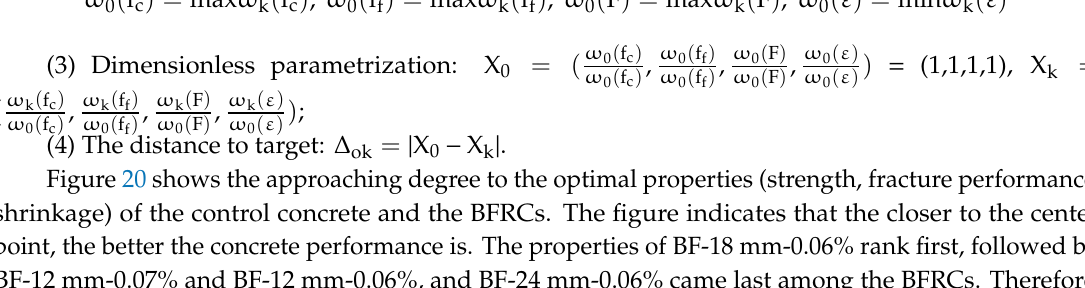
Figure 19. Strength, fracture energy and shrinkage reduction rate of control concrete and BFRCs.